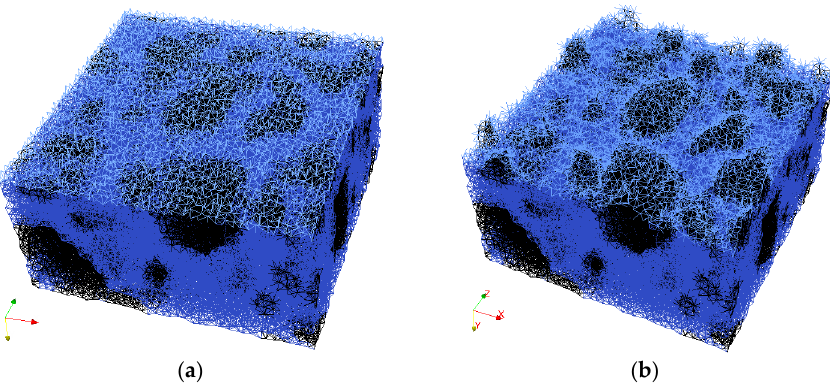
Figure 3. Generated lattice model for ( a ) a smooth; and ( b ) a “sandblasted” surface substrate.